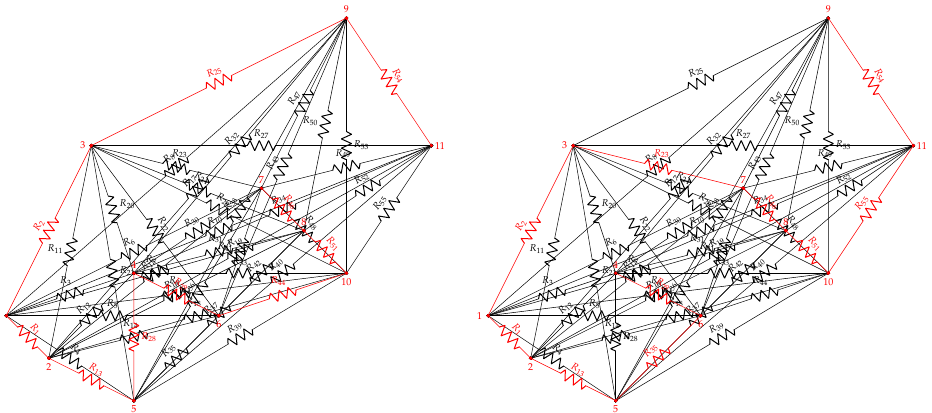
Figure 10. Path for delivering merchandise on the Puebla map. Figure 11 shows two alternate full path resistive grid configurations using differ- ent starting nodes. In the case of the resistive grid on the left side, the starting node is the number seven, which generates a connection tree formed by the resistors in red { R } and a path sequence { 7,8,10,6,4,5,2,1,3,9,11 } . 46 , R 51 , R 44 , R 29 , R 28 , R 13 , R 1 , R 2 , R 25 , R 54 On the other hand, the resistive grid on the right side starts at node four generating a con- nection tree compound of the resistors in red { R 29 , R 35 , R 13 , R 1 , R 2 , R 23 , R 46 , R 51 , R 55 , R 54 } and a path sequence { 4, 6, 5, 2, 1, 3, 7, 8, 10, 11, 9 } . In addition, the total lengths of each path shown on the left-side and the right-side Figure 11 are 17.14 km and 16.21 km, respectively.